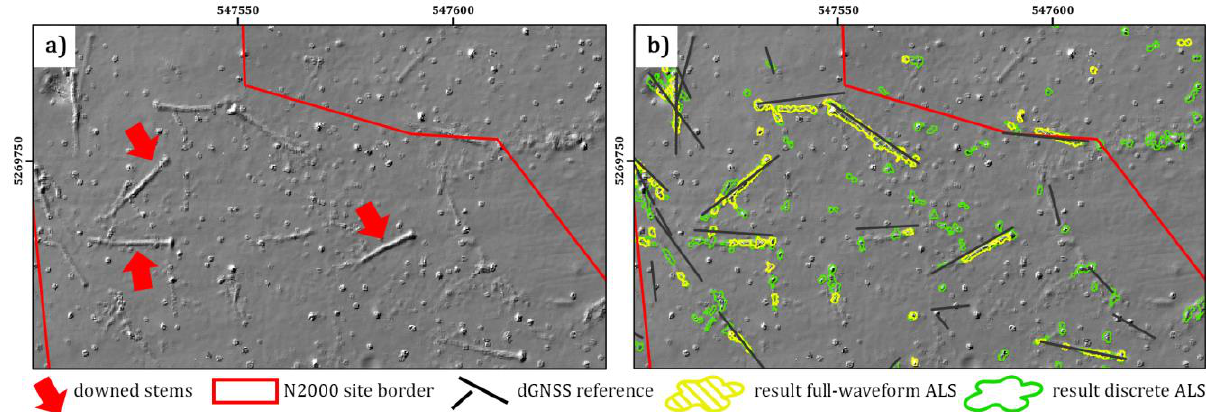
Figure 3: (a) shading of the DHM cand showing downed stems in the study site (some examples marked by red arrows); (b) comparison of results from discrete and full-waveform input data. Black lines represent dGNSS reference measurements of stems.